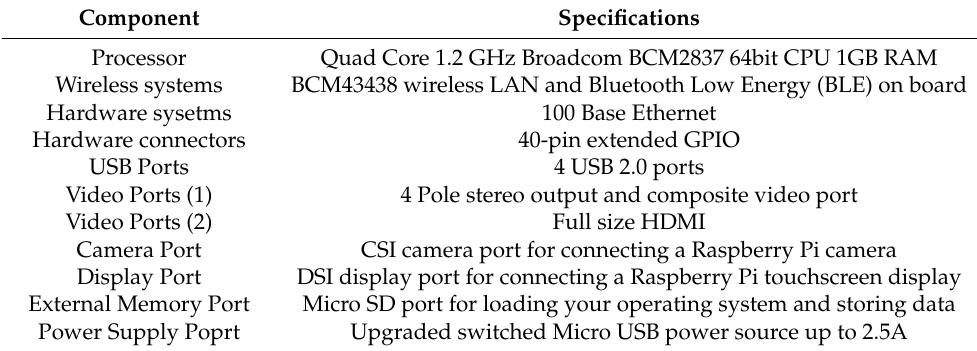
Table 4. Raspberry PI 3 specifications.